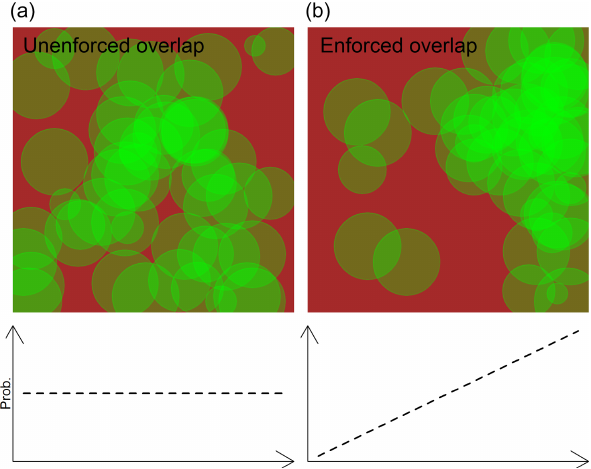
Figure 2. Visual representation of the effects of enforcing overlap within a (100m × 100m) TROBIT site with a given canopy area index (CAI). (a) Overlap is not enforced, and individual crowns follow a uniform random distribution. (b) Overlap is enforced by linearly increasing the probability of a canopy being located more on one side of the site (i.e. here the right side of the site) than the other. This results in tree canopies “overlapping” to a greater extent, which affects how accurately CAI represents actual canopy